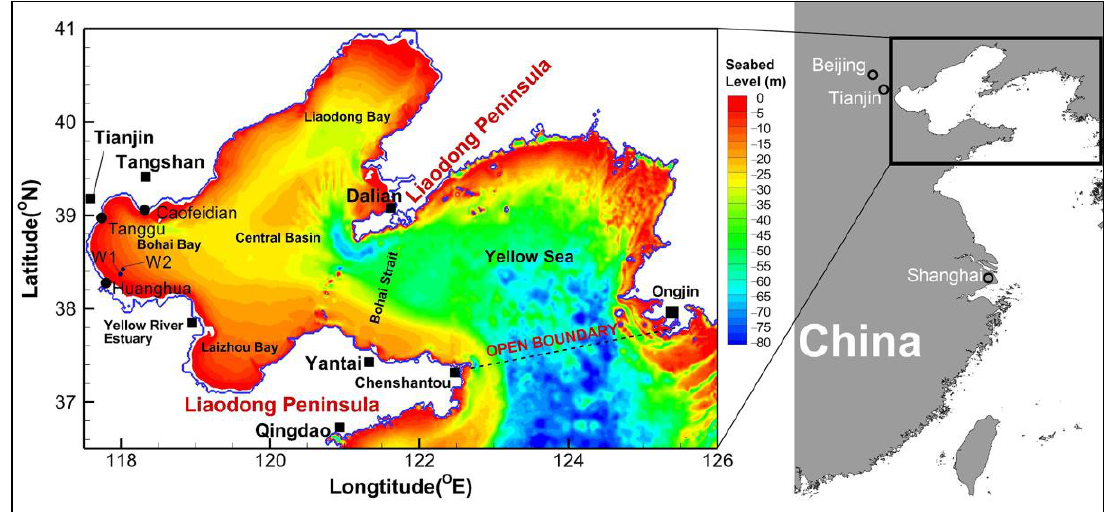
Figure 1. Location of the Bohai Sea and the observation stations (wave, water level and current). The orange solid dots represent the wave observation stations [27] and the red dots represent the surge observation stations [28,29] .